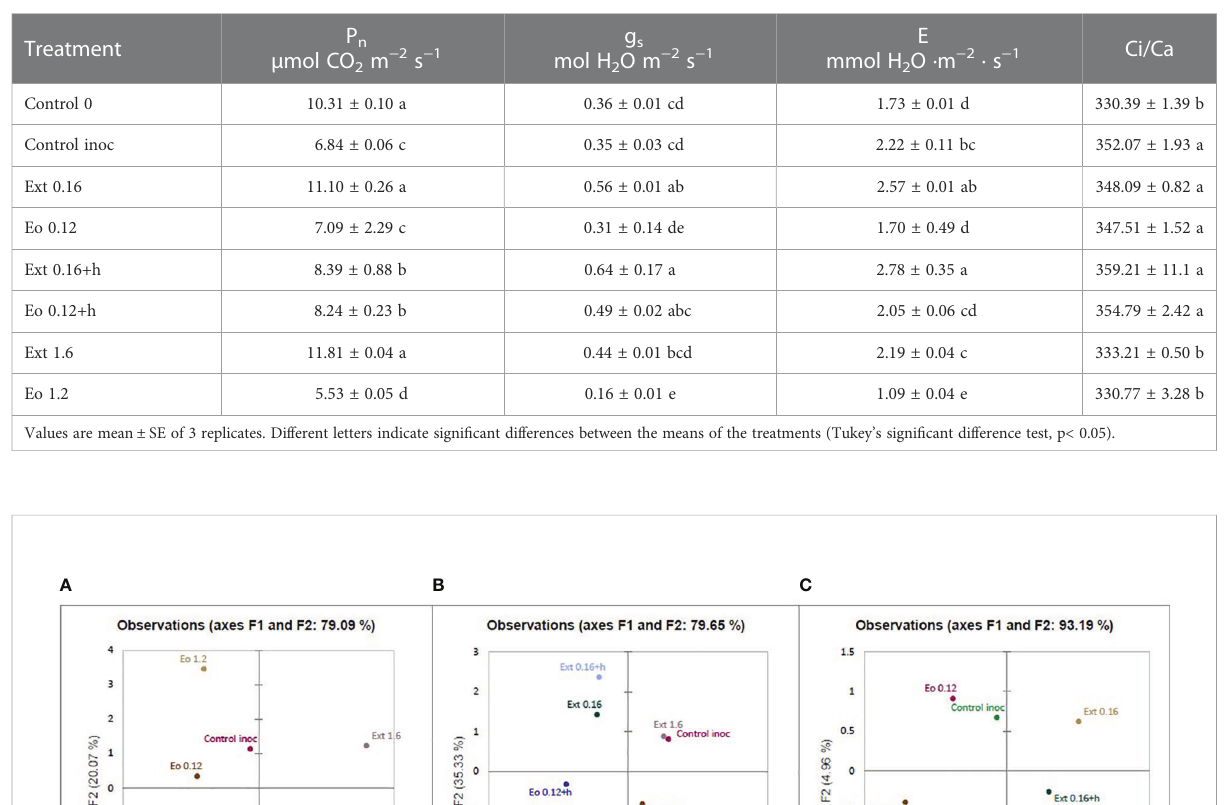
TABLE 4 Photosynthetic capacity of strawberry leaves: Photosynthetic rate (P n ), Stomatal conductance g s , transpiration rate (E), intercellular CO 2 (Ci/Ca).